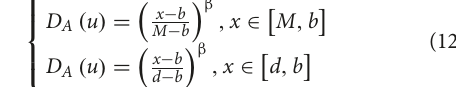
Table 1 . Common evaluation indicators of coral reef